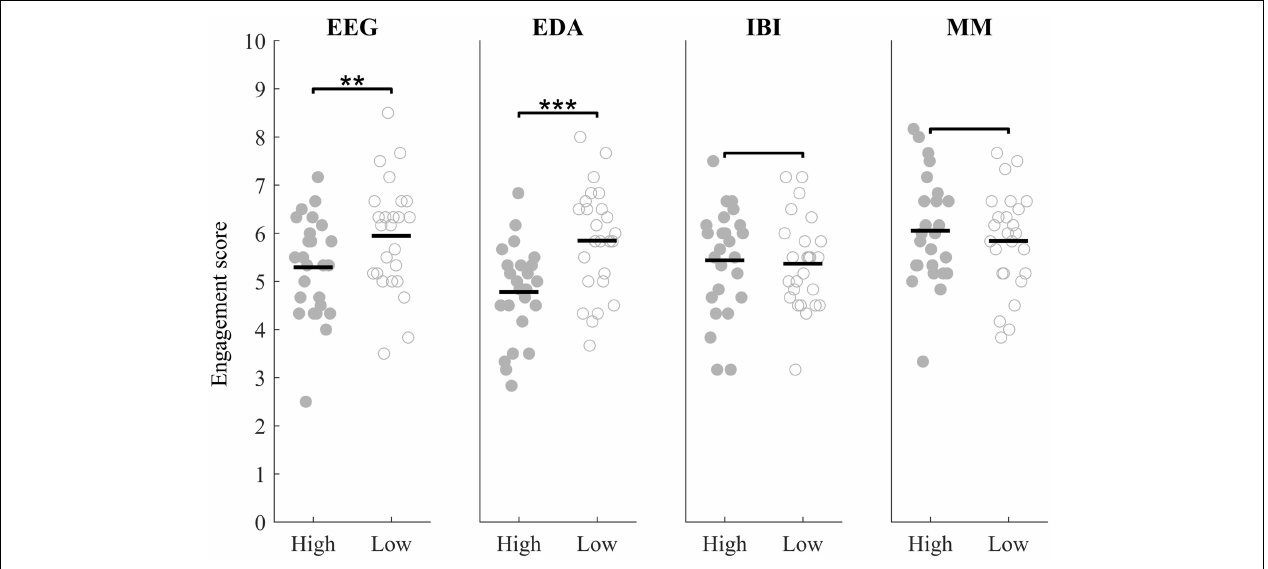
FIGURE 3 | Self-reported engagement scores for audio clips corresponding to moments in the audiobook with high PS (closed markers) or low PS (open markers) in EEG, EDA, IBI and the multimodal metric (MM) ( ∗∗ p < 0 . 01, ∗∗∗ p < 0 .